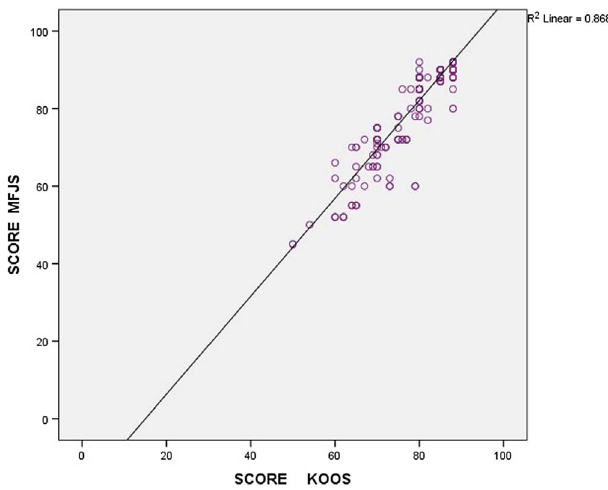
Figure 2. Pearson correlation between MFJS and KOOS.